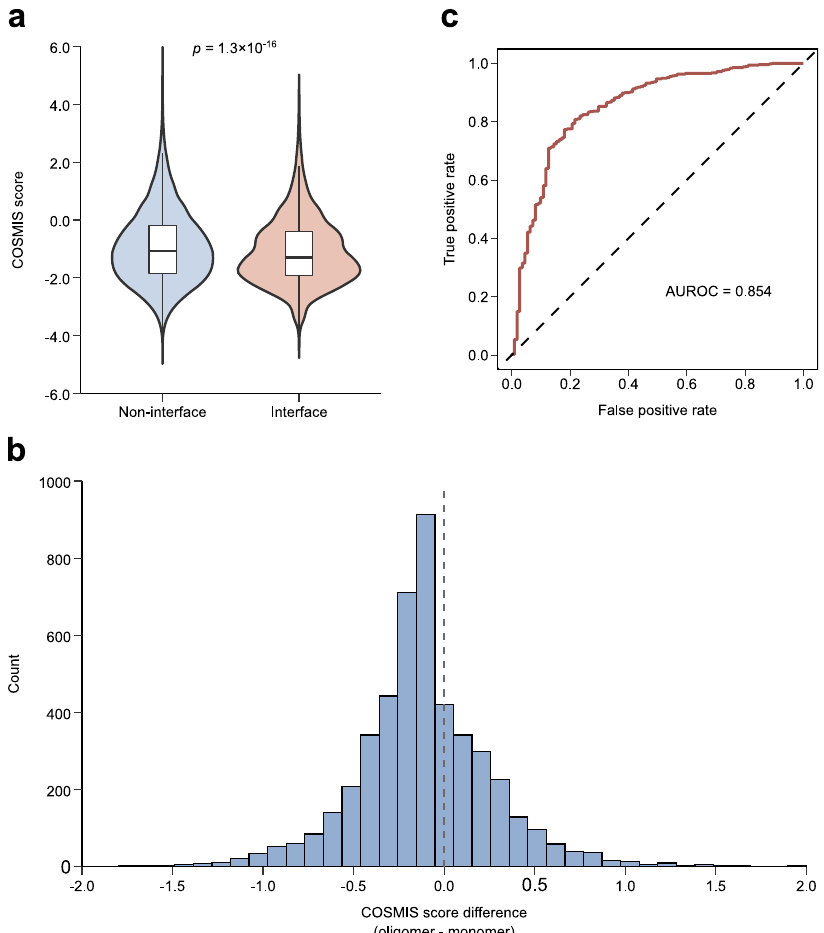
Fig. 8 Applying COSMIS to custom-built oligomeric structural models facilitates interpretation of potassium channel variants. a COSMIS score distributions for interface and non-interface amino acid sites in 41 oligomeric potassium ion channels. Overall, interface sites ( n = 4762) involved in oligomerization (making more 3D contacts in oligomers than in monomers) have a signi fi cantly lower COSMIS scores than non-interface sites ( n = 14,331) (median − 1.3 vs. − 1.1, p ¼ 1 : 3 ´ 10 (cid:1) 16 , two-sided Mann – Whitney U test). b COSMIS scores of interface sites computed based on oligomers are generally lower than those computed based on monomers (median difference − 0.13, p ¼ 8 : 1 ´ 10 (cid:1) 8 , two-sided Mann – Whitney U test). c COSMIS score performs well (AUROC 0.854) at predicting the pathogenicity of 111 benign and 489 pathogenic potassium channel missense variants curated from ClinVar. AUROC area under the receiver operating characteristic. Source data are provided as a Source Data fi